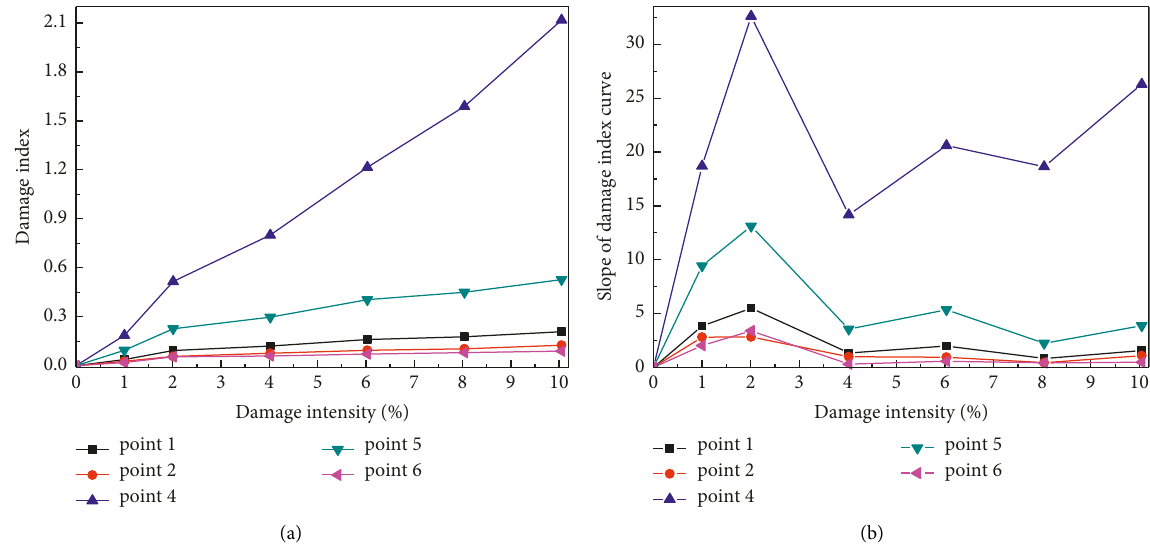
Figure 11: The relationship curves of damage intensity between damage indexes of different measurement points (the second time test at excitation point II). (a) Curves of damage index. (b) Slopes of damage index